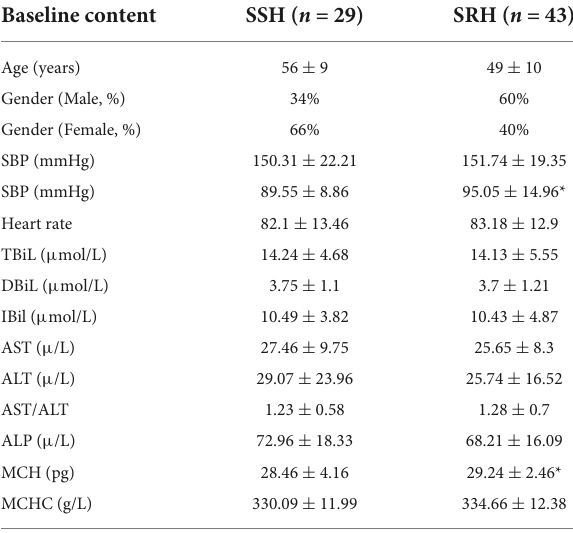
TABLE 1 Baseline characteristics of study participants in salt-sensitive hypertension (SSH) and salt-resistant hypertension (SRH).